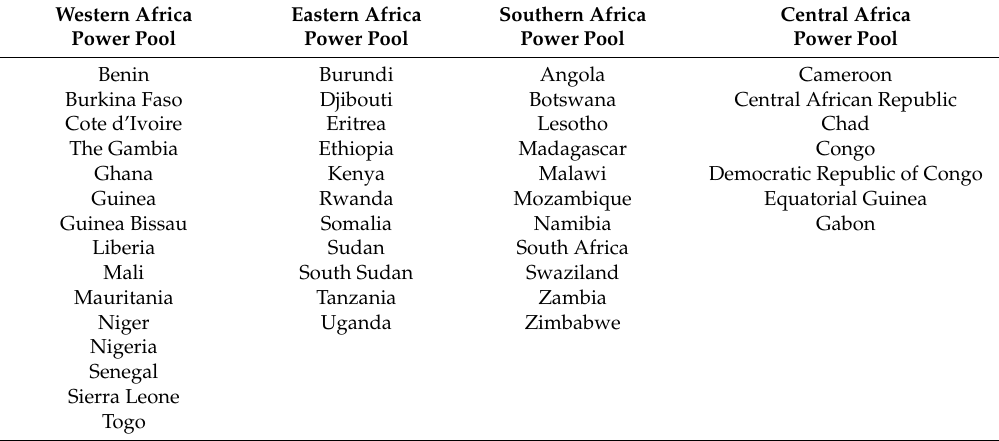
Table A1. List of countries per Sub-Sahara African power pool